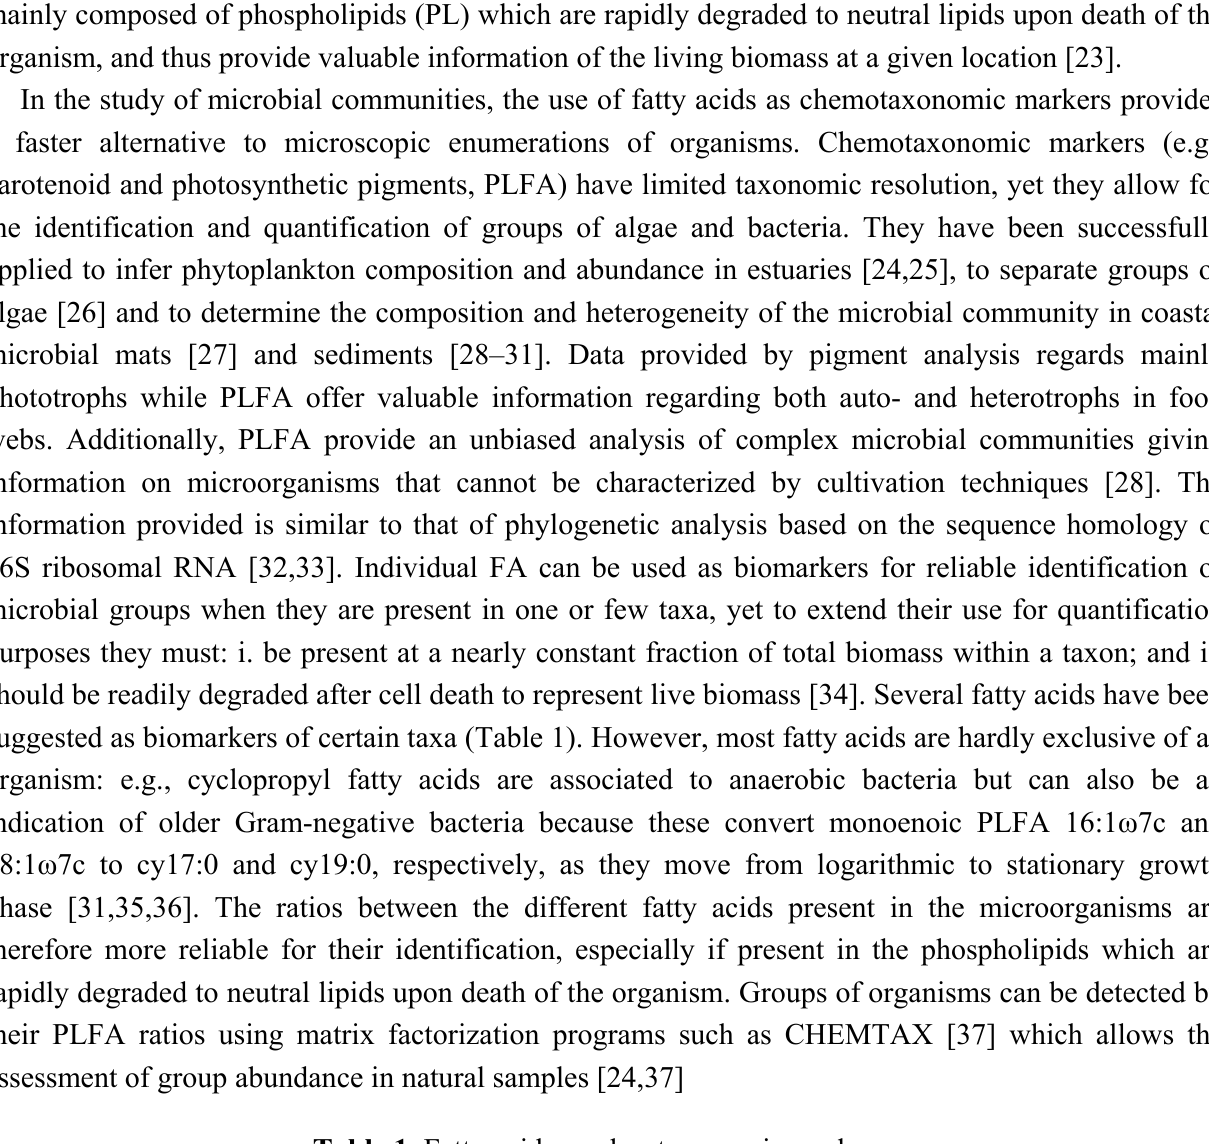
Table 1. Fatty acids used as taxonomic